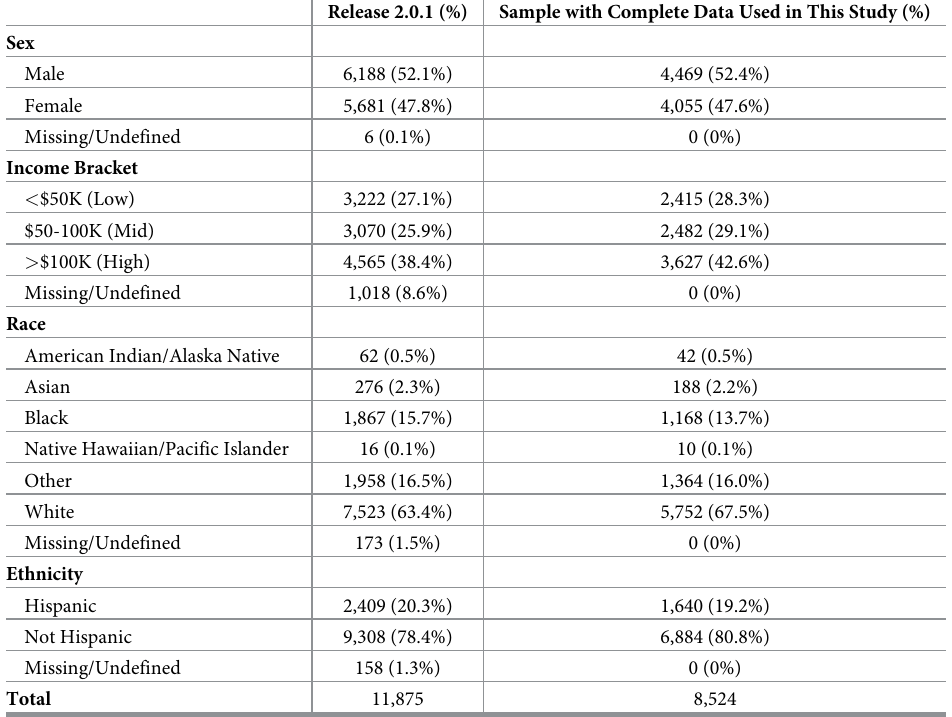
Table 1. Demographics for the Adolescent Brain Cognitive Development (ABCD)